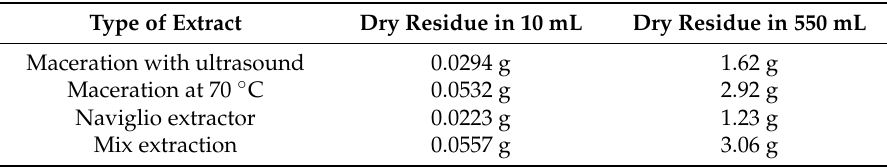
Table 2. Dry residue in 10 mL and in 550 mL of four types of